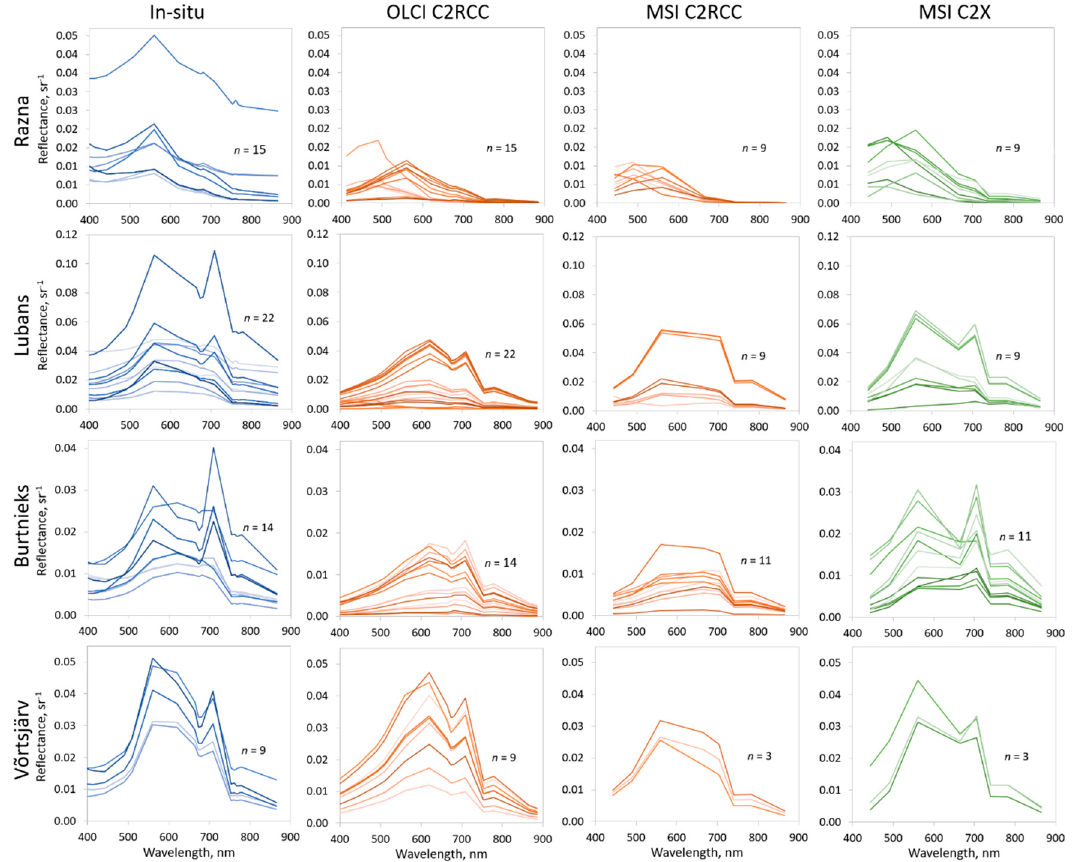
Figure 2. The reflectance spectra on different wavelengths measured in-situ and derived from satellites for each match up point. The in-situ reflectance spectra are calculated to the OLCI bands using OLCI spectral response functions; n marks the number of spectra.